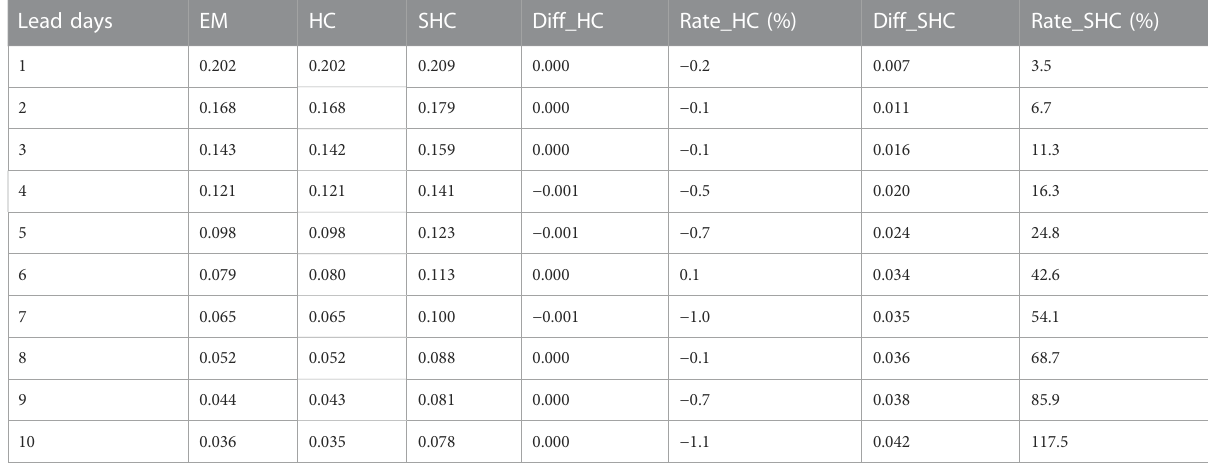
TABLE 1 TS, its increment (Diff_HC and Diff_SHC), and its growth rate related to 25 mm precipitation using EM, HC, and SHC to analyze data from summer 2019 to 2021.